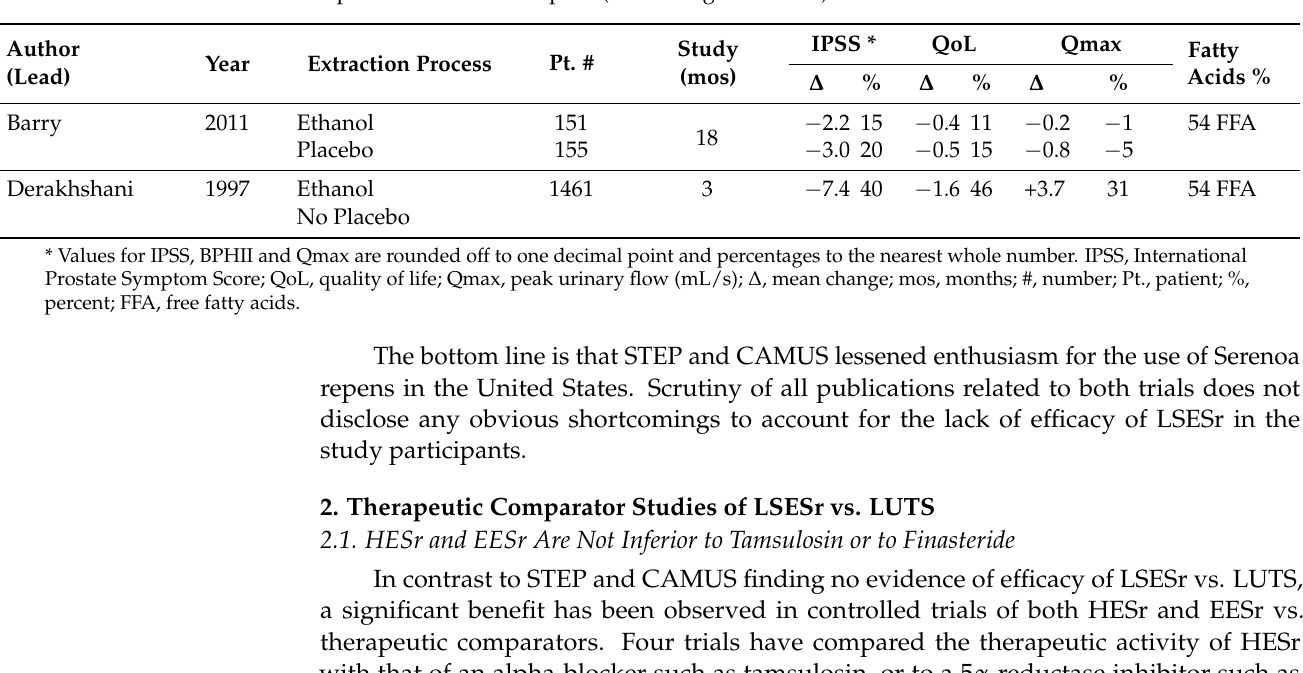
Table 2. The striking difference in the endpoints of IPSS, QoL and Qmax for Barry [2] and Derakhshani [4] using the identical ethanolic extraction product of Serenoa repens (Prosta Urgenin ® Uno).